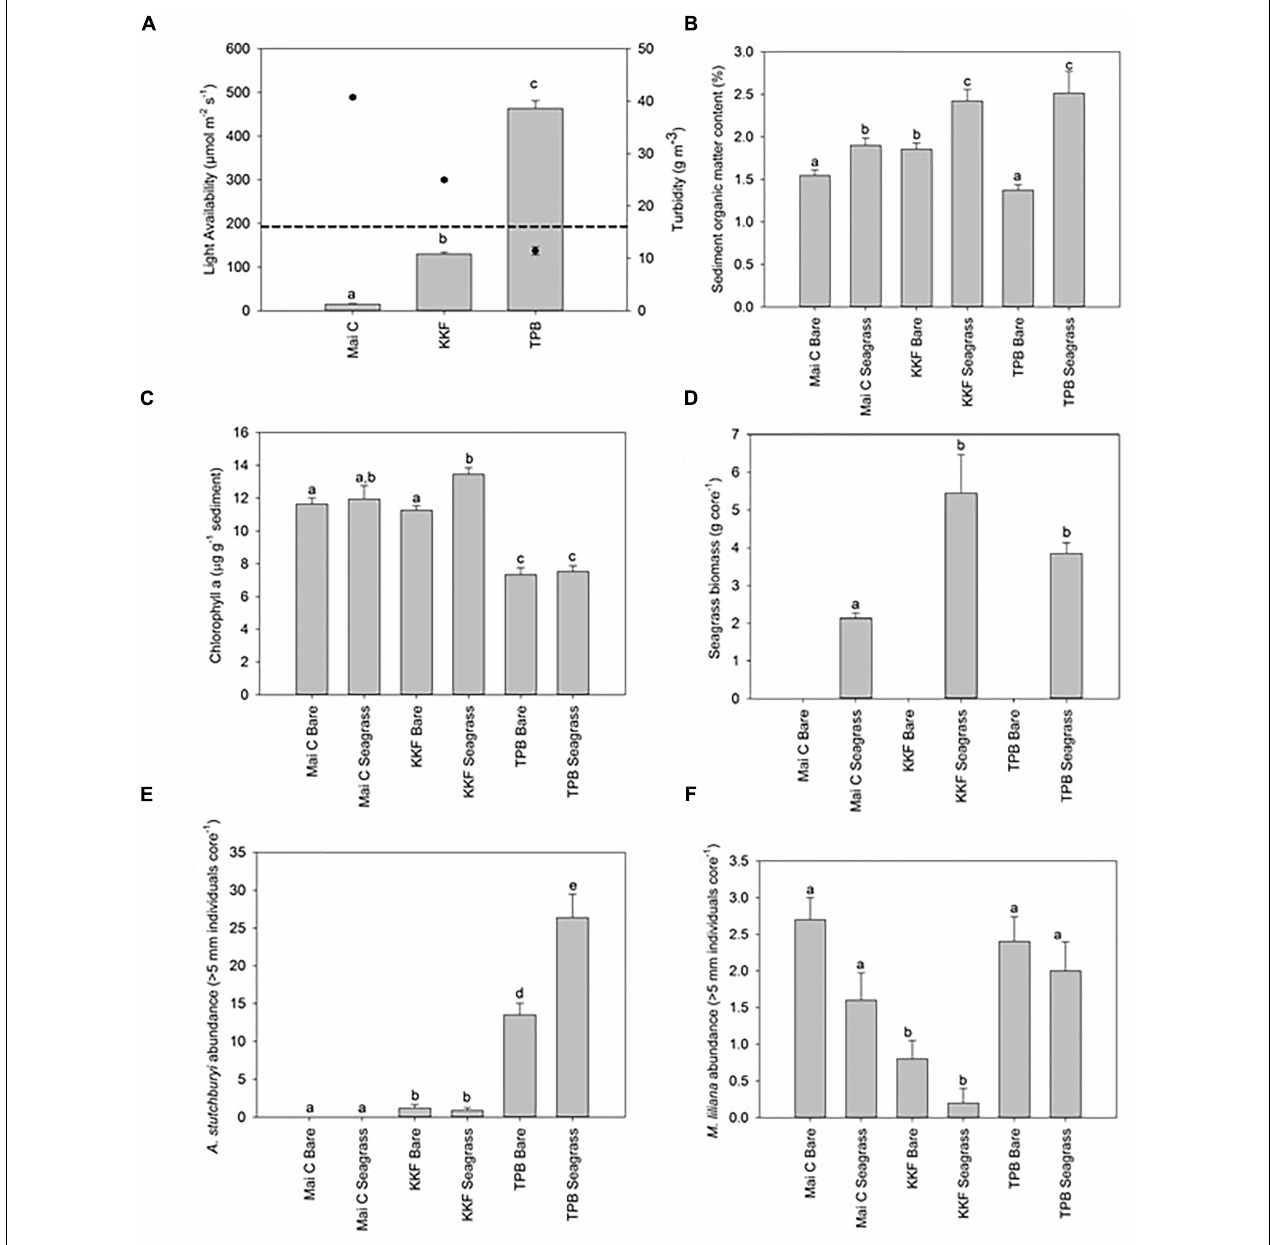
FIGURE 2 | Physical and biological site characteristics ± 1 standard error. n = 10 per site/habitat type. (A) Benthic light availability [Dashed line on light availability graph indicates the light required for photosynthesis saturation in Zostera muelleri ( ≥ 195 µ mol m − 2 s − 1 ; Schwarz, 2004)]. Turbidity overlaid onto light availability graph as point data – right hand axis, (B) Sediment organic matter content, (C) Seagrass biomass, (D) Chlorophyll a concentration, (E) Austrovenus stutchburyi abundance, (F) Macomona liliana abundance. a , b , c same letter indicates no significant difference (p >